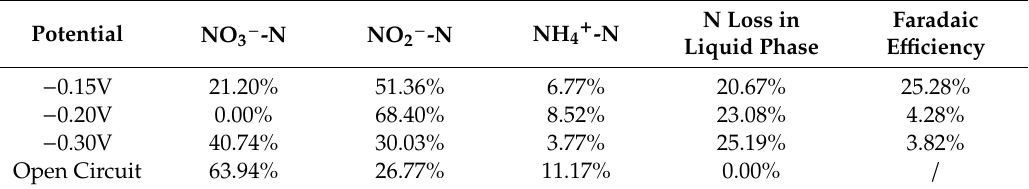
Inorganic N compound distribution, Faradaic e ffi ciency and electrons accepted by N